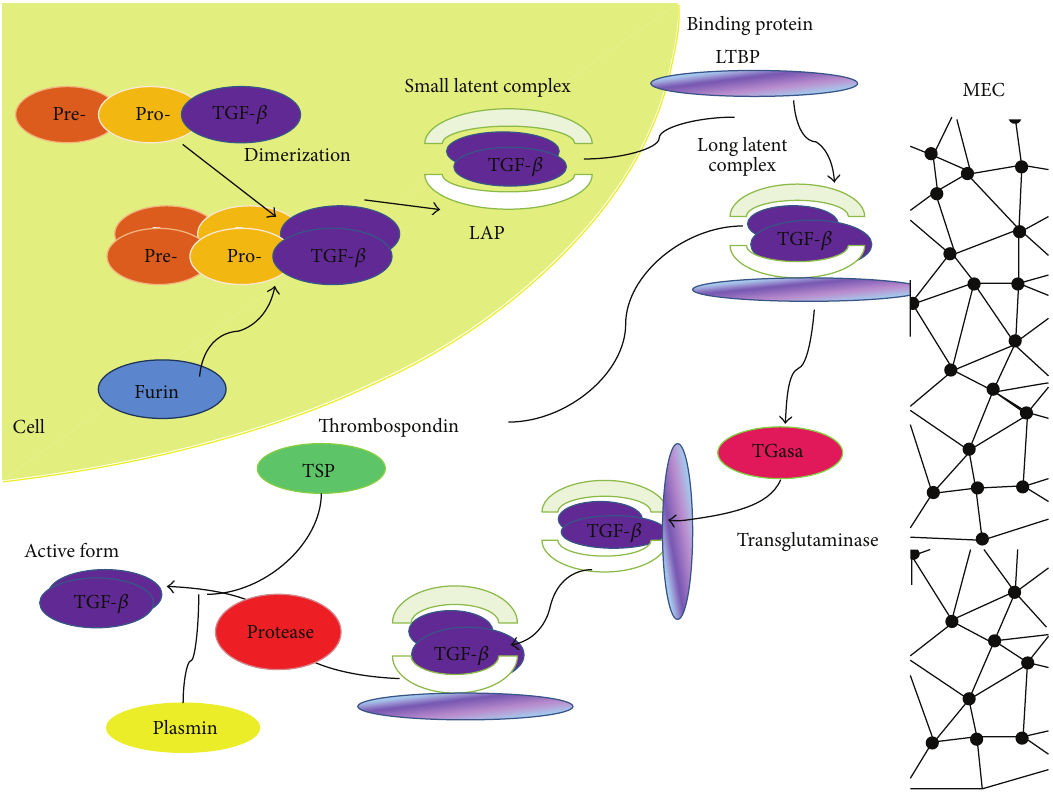
Figure 1: Synthesis and activation of TGF- 𝛽 . TGF- 𝛽 is synthesized as an inactive precursor with a preregion (signal peptide) and a proregion (N-terminal peptide LAP). Processing of the inactive form begins with the proteolytic cleavage of the signal peptide from pre-pro-TGF- 𝛽 . After dimerization, TGF- 𝛽 is cleaved by proteases (such as furin) at the C-terminal region in mature peptides and at the N-terminal LAP (latency-associated peptide). LAP-bound TGF- 𝛽 forms small latent complexes (SLCs) that are transported to the extracellular matrix (ECM) where they can covalently bind to the binding protein (LTBP) to form a large latent complex released from the ECM by proteases. Then, the mature protein is cleaved from the LTBP in acidic conditions in vitro or by thrombospondin (TSP) or plasmin in vivo . Once the active TGF- 𝛽 family member is released from the ECM, it can engage in